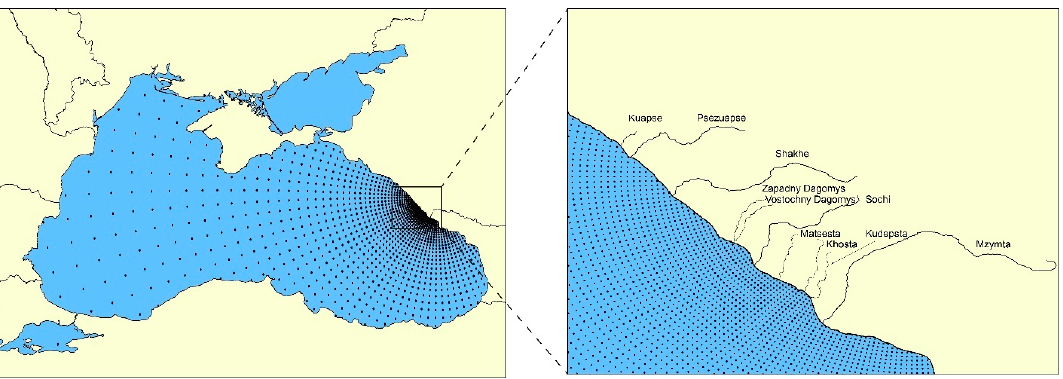
Figure 3. INMOM model domain at the Black Sea (every 15th grid point is shown) ( left panel ) and at the study area (every 5th grid point is shown) with an indication of the location of the considered rivers ( right panel ).